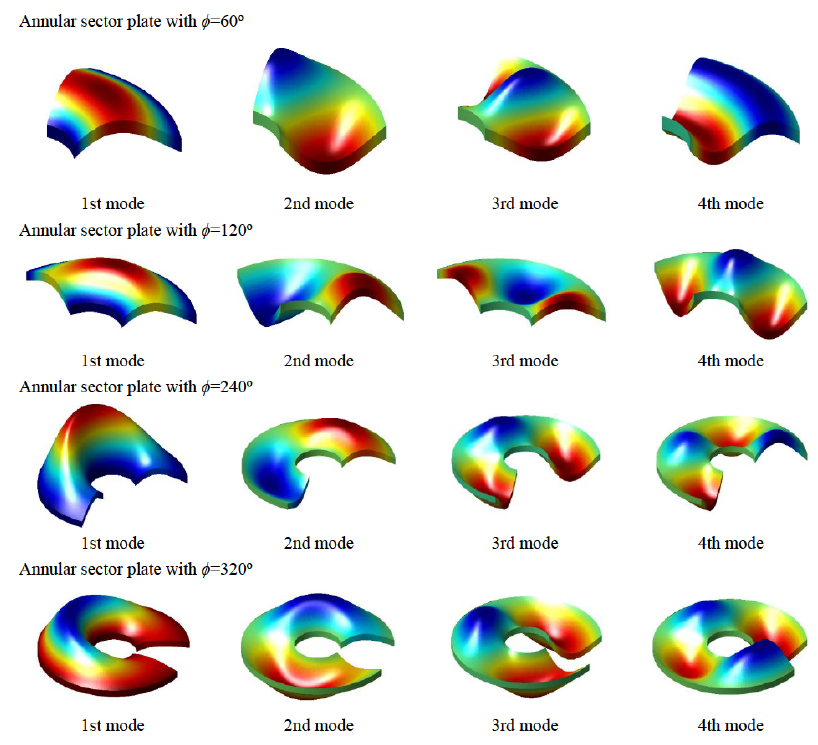
Figure 5: Mode shapes of FGX-CNT reinforced composite annular sector plates with CE 2 CE 2 boundary condition